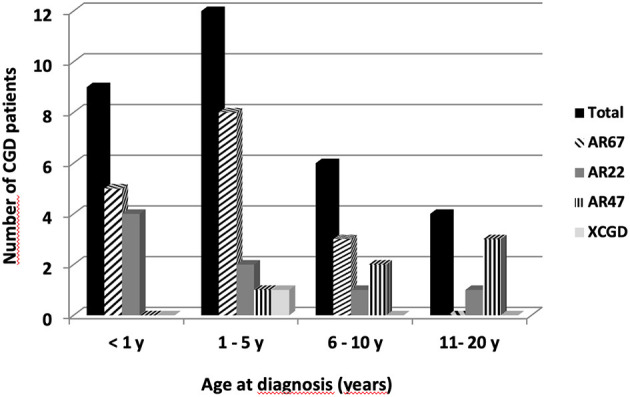
Age at diagnosis of the 31 CGD patients from Jordan, Iraq, and Lybian according to the CGD types. Twenty-two Jordanian, seven Lybian, and two Iraqi CGD patients from 21 different families were investigated. Sixteen patients suffered from AR670 CGD, eight patients from AR220 CGD, six from AR470CGD, and only one patient had X-CGD.